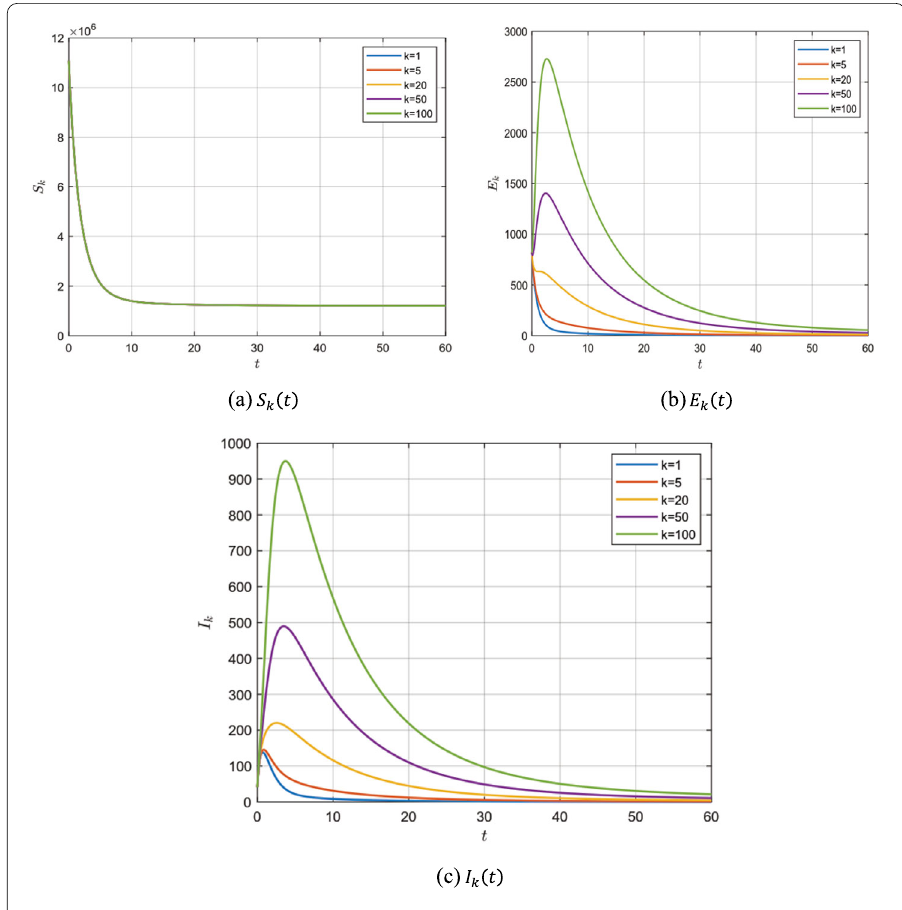
Figure 2 α = 0.95 and R 0 =